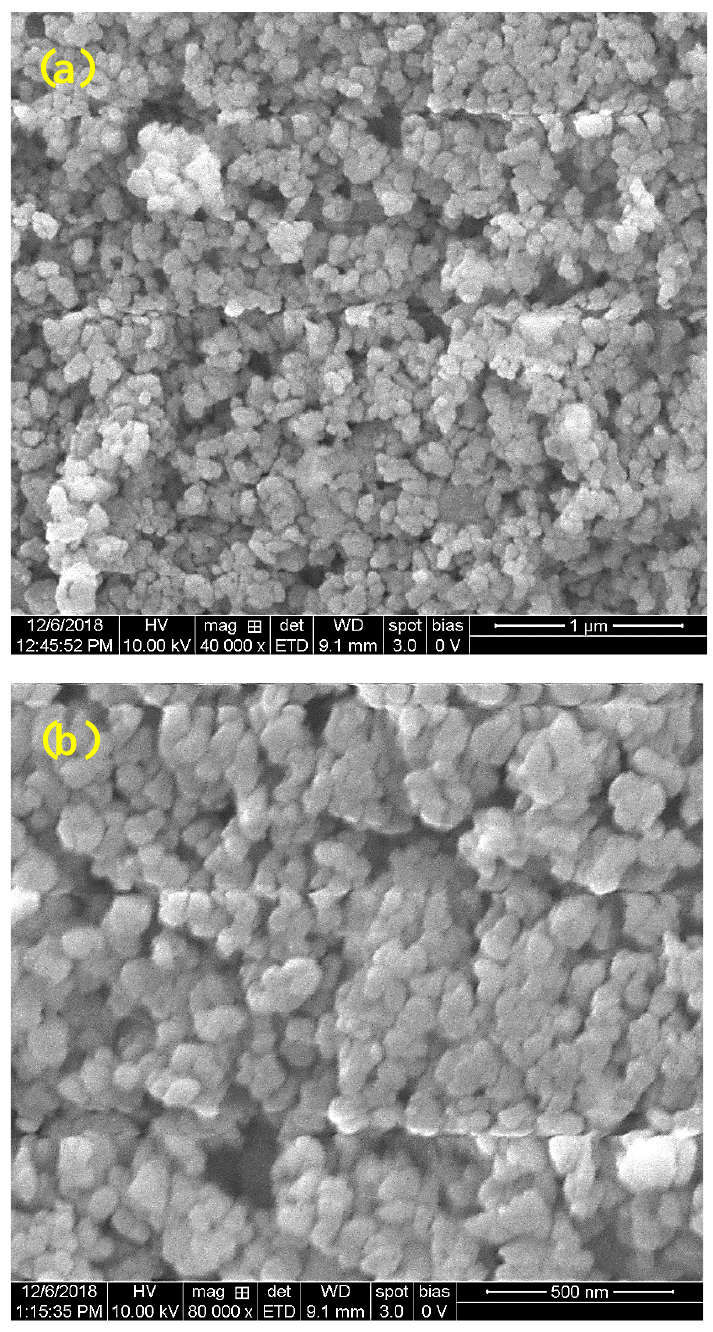
Figure 4. FESEM images of Ni 2+ -doped HApNPs ( a ) 40,000x, ( b ) 80,000x.